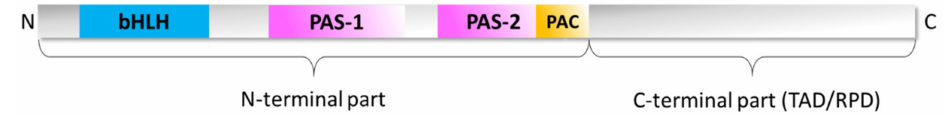
Figure 1. Schematic representation of the basic helix-loop-helix / Period-ARNT-Single minded (bHLH-PAS) protein domain structure. The N-terminal part is characterized by the presence of defined domains: bHLH (blue), PAS-1 and PAS-2 (rose) associated with PAC (C-terminal to PAS domain) motif (yellow). The C-terminal part is highly variable and often contains transactivation / repression domains (TAD / RPD). Based on